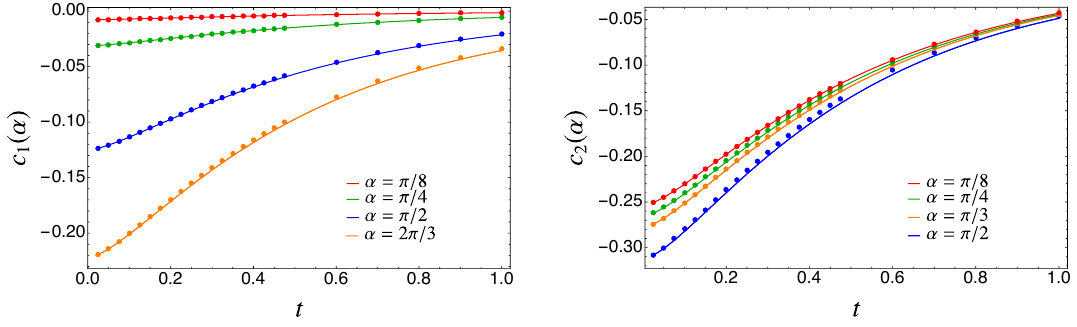
Figure 1 . The universal constant c n ( (cid:11) ) extracted from the numerical solution of the Painlev(cid:19)e equation (4.6) for di(cid:11)erent values of (cid:11) and n as a function of t = m‘ (full lines). The numerical data are obtained varying ‘ between 200 and 400 lattice points and properly choosing m in such a way t = m‘ 2 (0 ; 1). For larger (cid:11) and n , we need larger subsystem size to have a good